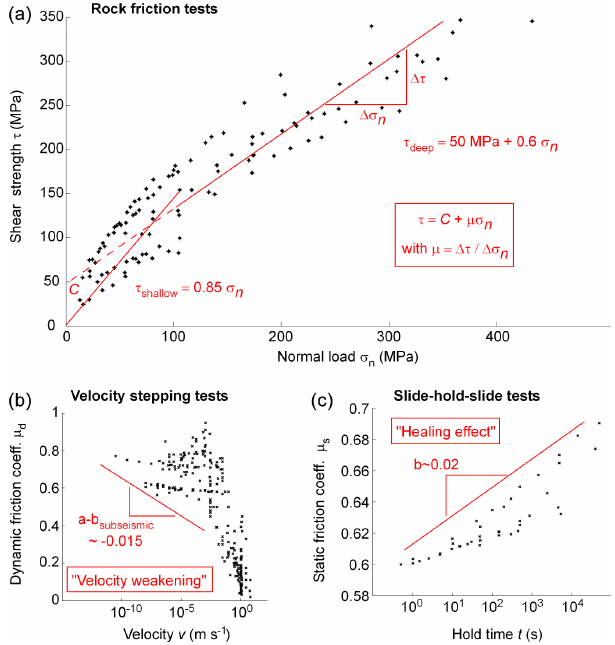
Figure 8. Rock friction data: (a) data from rock friction tests in a Mohr–Coulomb plot showing the pressure dependence of frictional strength (“Byerlee’s law”, data as compiled by Ritter et al., 2016, and references therein). The slope corresponds to the friction co- efficient, the y -axis intercept to the cohesion of the rock and rock interfaces. (b) Data from velocity stepping tests (as compiled by Marone, 1998; Spagnulo et al., 2016, and references therein) in- dicating the velocity-weakening behaviour of rock interfaces. The slope is proportional to the parameter ( a – b ) in the RSF friction law. (c) Data from slide–hold–slide test (data as compiled by Marone, 1998, and references therein) demonstrating healing of rock inter- faces. The slope is proportional to the parameter b in the RSF law. Data plotted here are published as open-access material in Rosenau et al.